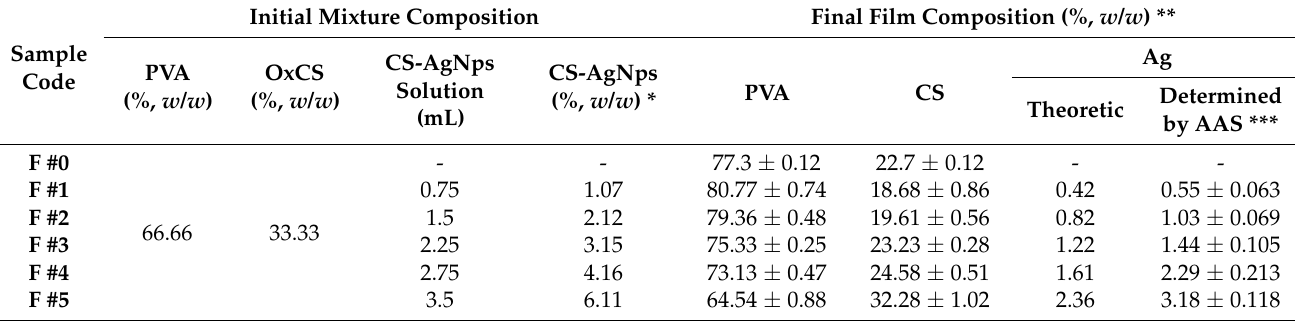
Table 1. Chemical composition of the initial mixture and of PVA/OxCS films without and with